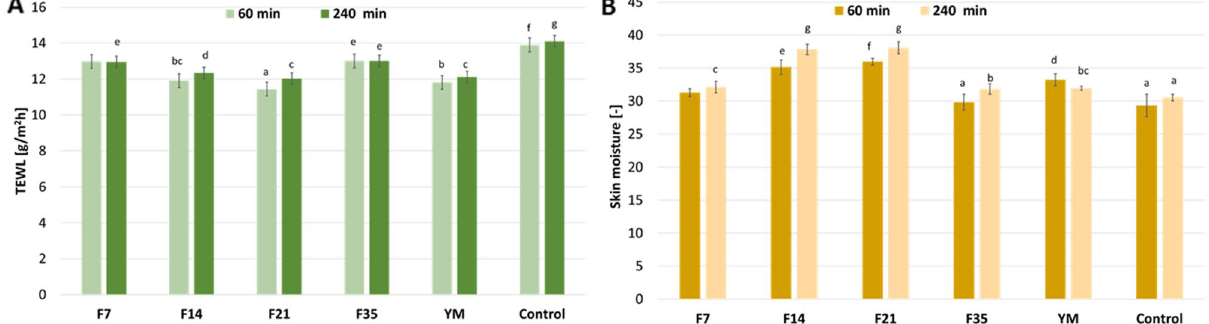
Figure 10. Influence of Yerba Mate extract and ferments (100 µg/mL) on transepidermal water loss (TEWL) ( A ) and skin hydration ( B ). The determinations were made in five replicates. Different letters on the charts indicate significant differences between groups ( p <